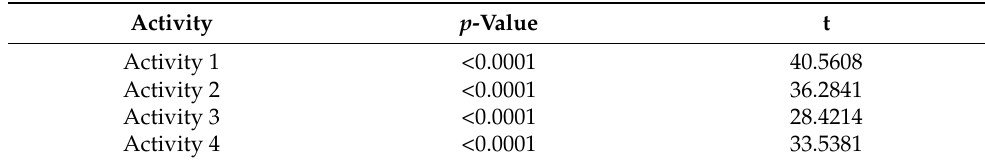
Table 7. Summary of t-test results for simulated occupancy for four typical teaching and learning activities in the same room, with and without contact time